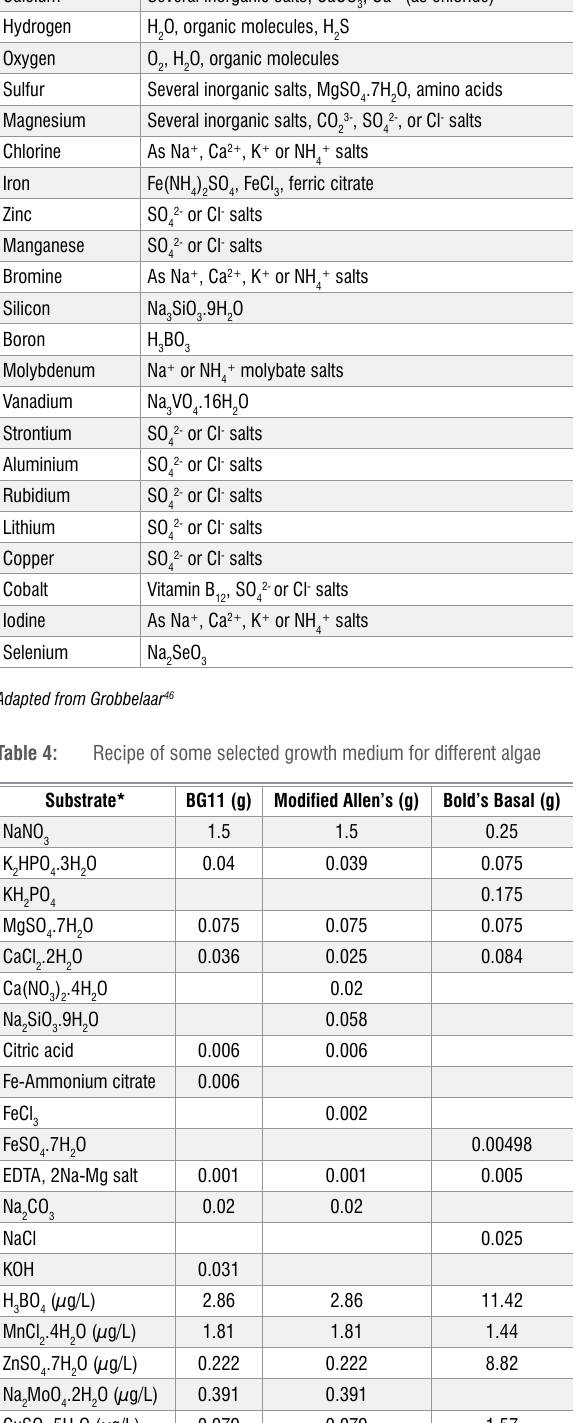
Table 3: List of nutrients required by algal cells for growth Elements Compounds Sodium Several inorganic salts, NaCl, Na Potassium Several inorganic salts, KCl, K Calcium Several inorganic salts, CaCO Hydrogen